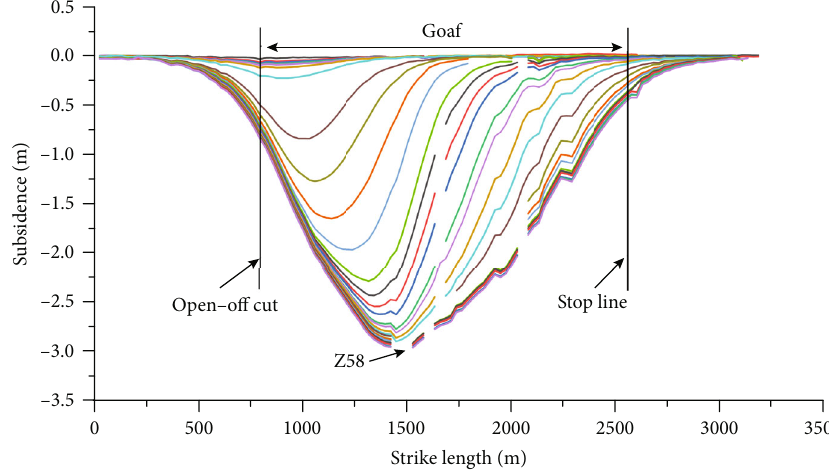
Figure 2: Strike observation subsidence curve of 1301 working